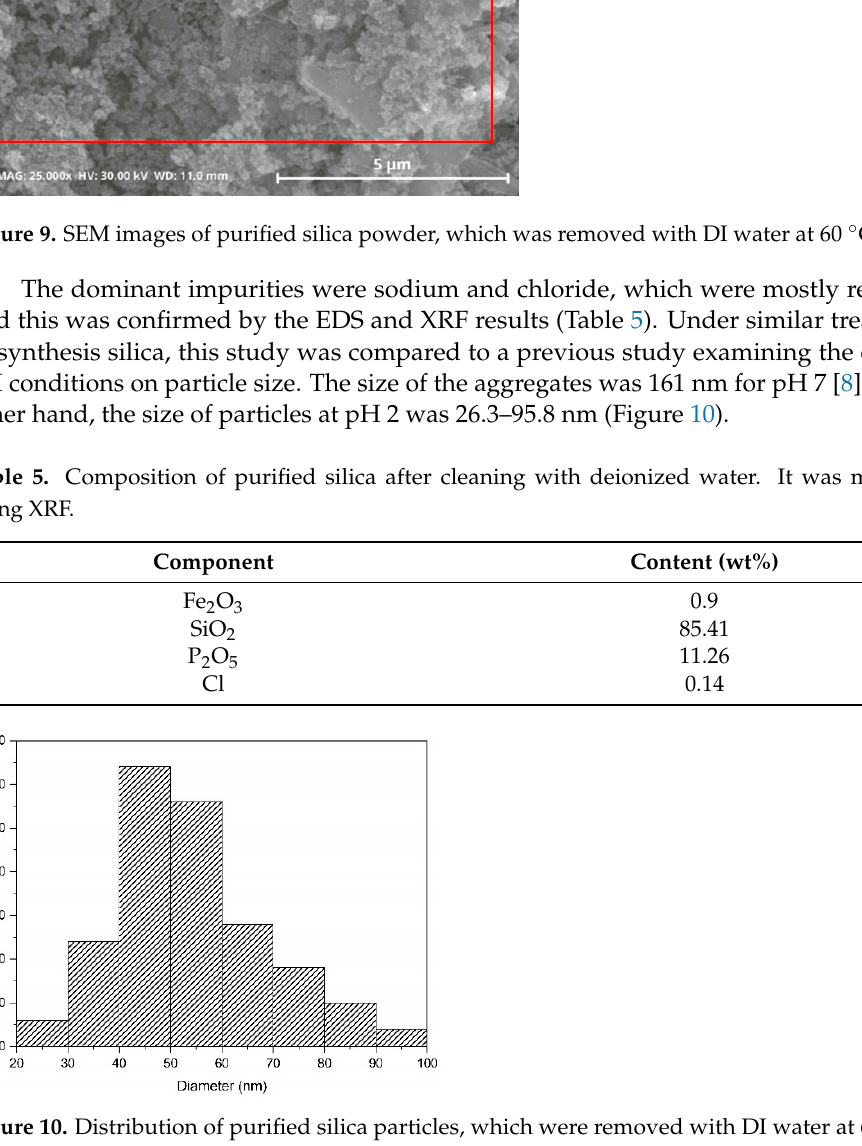
Figure 10. Distribution of purified silica particles, which were removed with DI water at 60 °C for 3 h. Analyzed using ImageJ. 3 h. Analyzed using